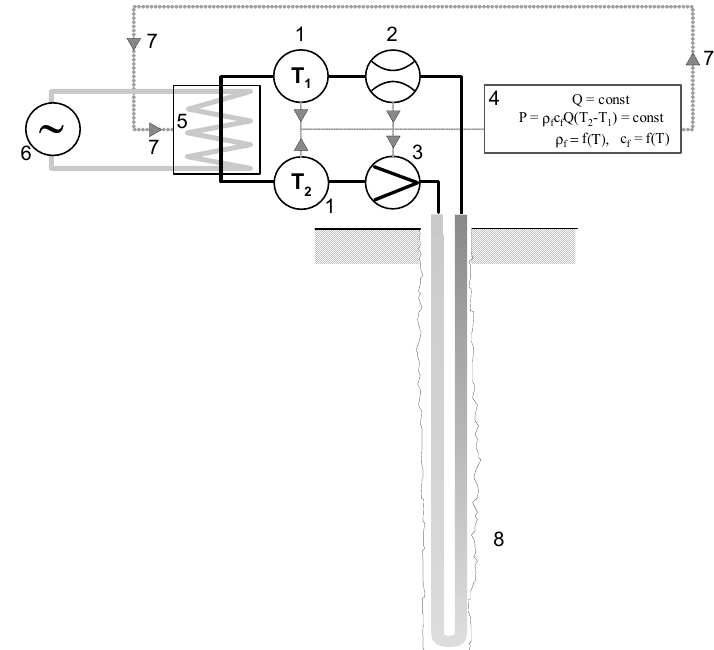
Figure 1. Schematic of thermal response test devices and operation. Legend: 1—thermometer with absolute error 0.1 °C, 2—flowmeter, 3—pump, 4—control computer (stabilization of thermal power